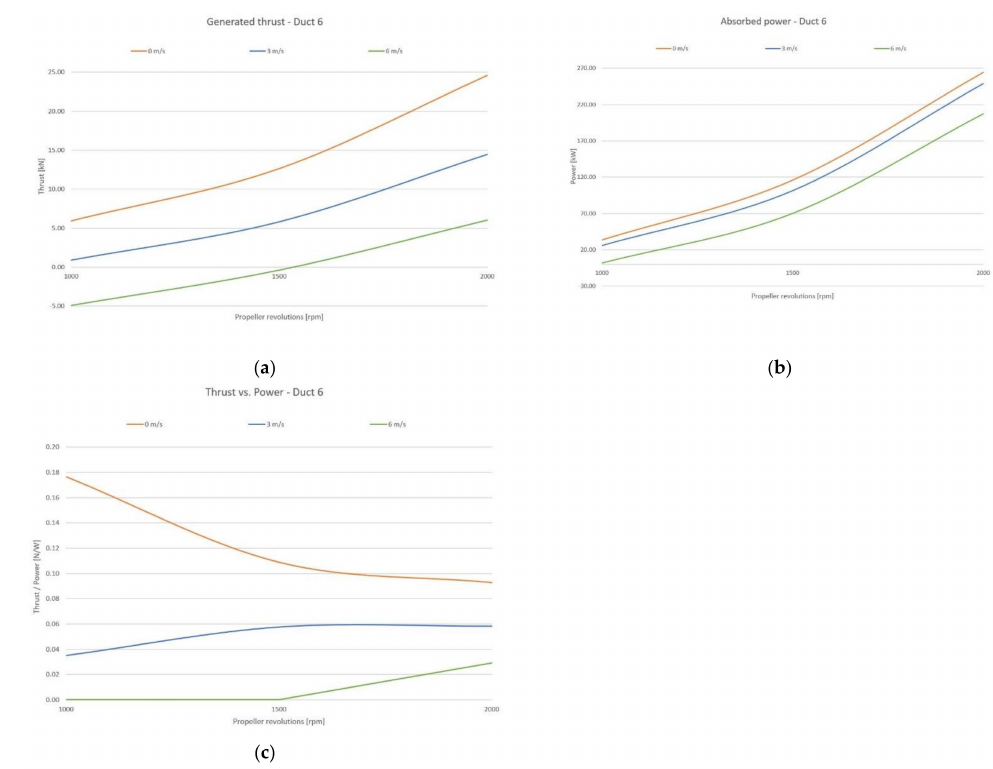
Figure 13. Performance characteristics of propeller with Duct 6. ( a ) Generated thrust for different speeds depending on the propeller speed; ( b ) absorbed power for different speeds depending on propeller speed; ( c ) generated thrust per unit of power